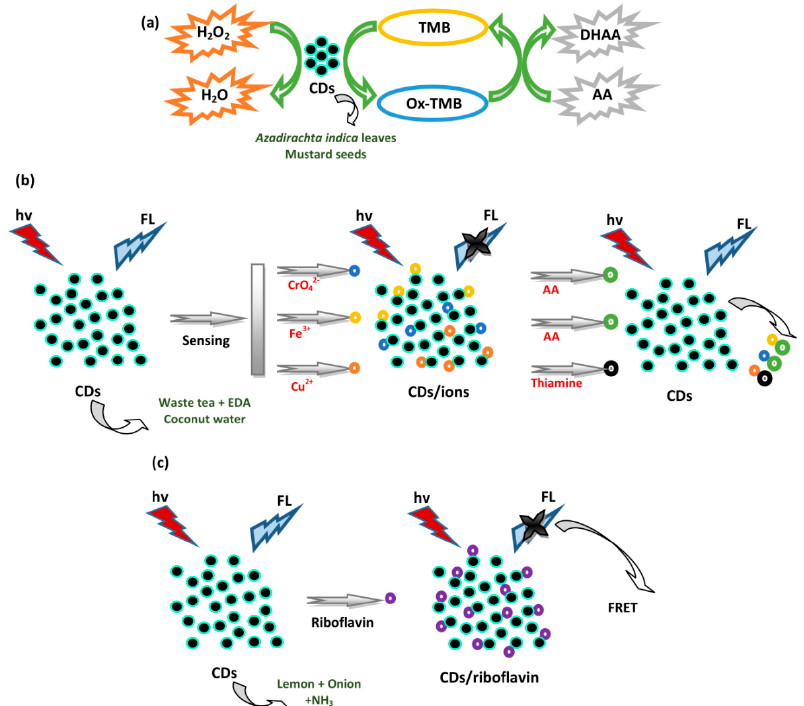
Figure 7. Schematic illustrations of plant part-derived CDs for detecting AA, thiamine, and riboflavin. ( a ) The TMB oxidation and colorimetric detection of AA. ( b ) The “turn-on” effect on the FL intensity of CDs for the detection of AA and thiamine. ( c ) The FL-quenching behavior of CDs was observed after interacting the CDs with riboflavin through the FRET system. Abbreviations: AA, ascorbic acid; TMB, 3,3 (cid:48) ,5,5 (cid:48) -tetramethylbenzidine; FRET, fluorescent resonance energy